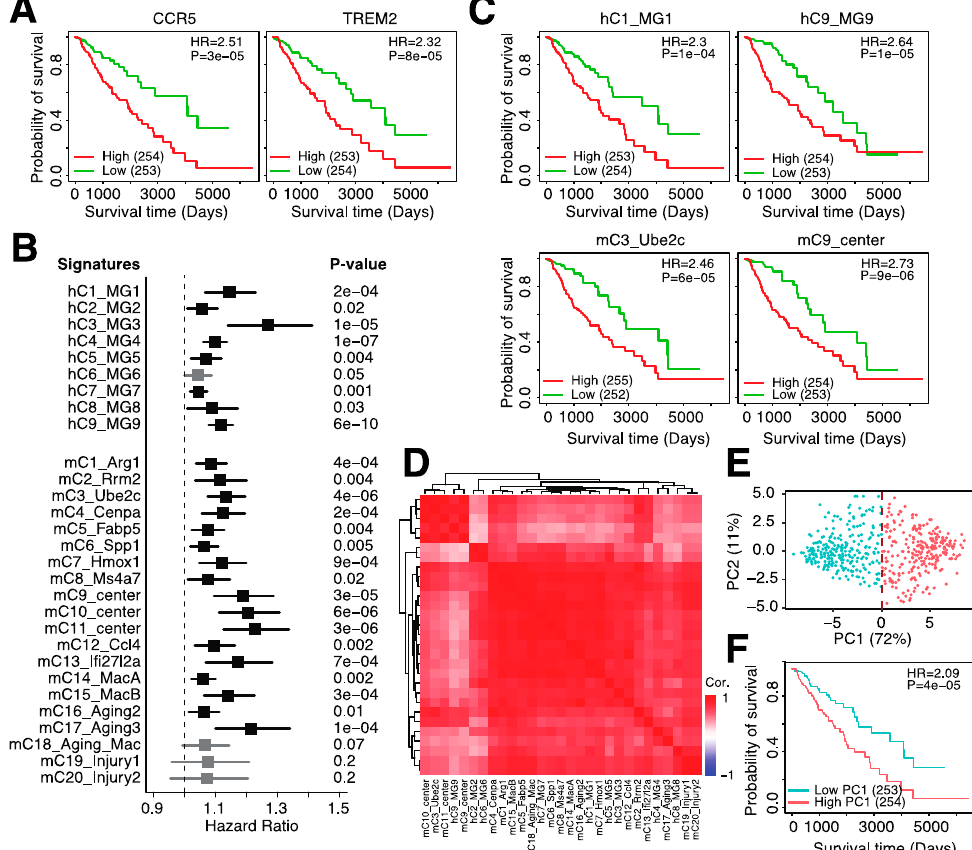
Figure 3. Microglia abundance is negatively associated with prognosis in low-grade gliomas. ( A ). Kaplan–Meier plot comparing overall survival between patients with low and high expression of CCR5 (left) and TREM2 (right). ( B ). Hazard ratios of univariate Cox regression models evaluating the association between overall survival and 9 human microglia signatures (“h”) and 20 mouse microglia signatures (“m”). ( C ). Kaplan–Meier plots depicting the association between overall survival and four microglia signatures. ( D ). Spearman correlation between the 29 microglia gene expression signatures. ( E ). Principle component analysis (PCA) on the expression of the 29 microglia gene expression signature in TCGA-LGG patients. ( F ). Kaplan–Meier plot showing the association between overall survival and principle component 1 (PC1) in TCGA-LGG.